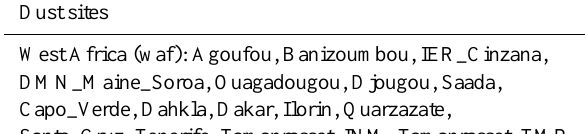
Table 1. AERONET sites used in this study. Dust sites